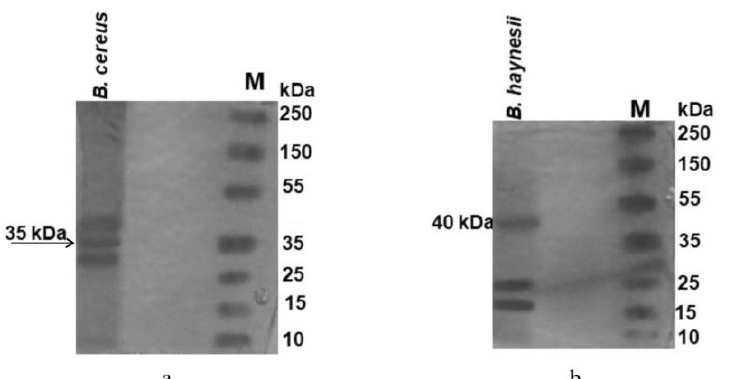
Figure 4. Purified 1-aminocyclopropane-1-carboxylate (ACC) deaminase derived from ( a ) Bacillus cereus strain (35 KDa) and ( b ) Bacillus haynesii (40 KDa).